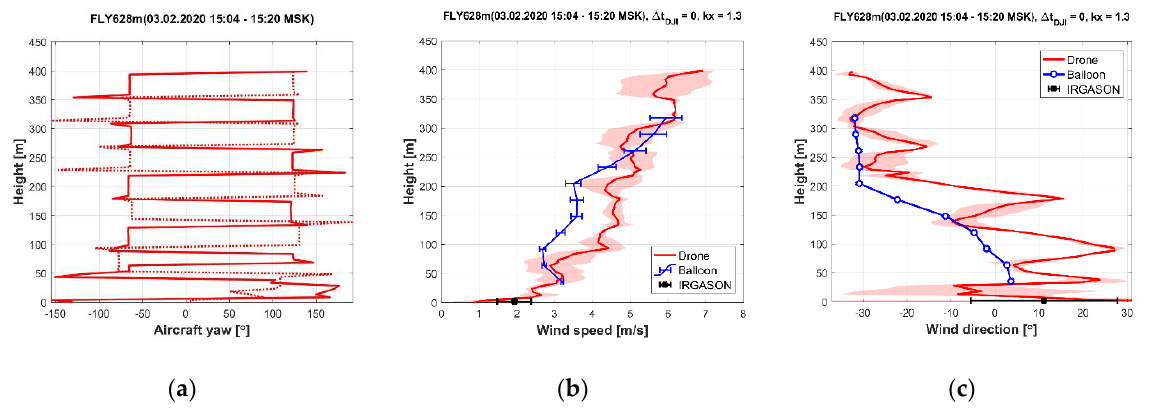
Figure 8. Comparison between aircraft yaw ( a ), wind speed ( b ) and direction ( c ) profiles for the cases at 3.02.2020, when drone was piloted by GS Pro software following predefined zigzag ascending and descending trajectory. For yaw ( a ), dotted and solid lines show the values for ascending and descending segments of the flight, respectively. Other designations are similar to Figure 5.